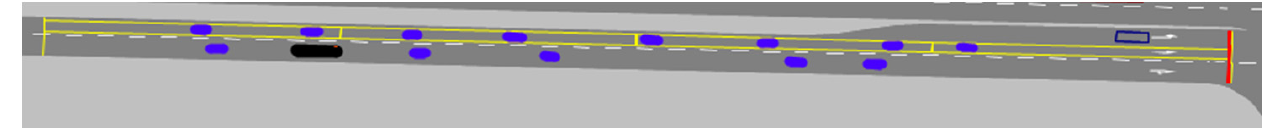
Figure 3. Graphical representation of the roadway in Vissim split into four parts on one lane (n1 = 1, n2 = 5, n3 = 4, n4 = 3).